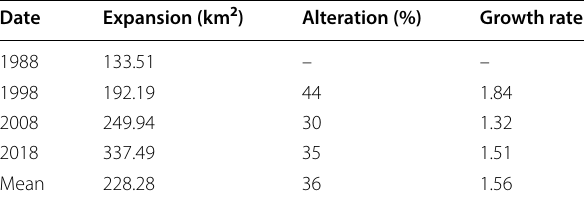
Table 2 Urban expansion in the study area based on the satellite imageries